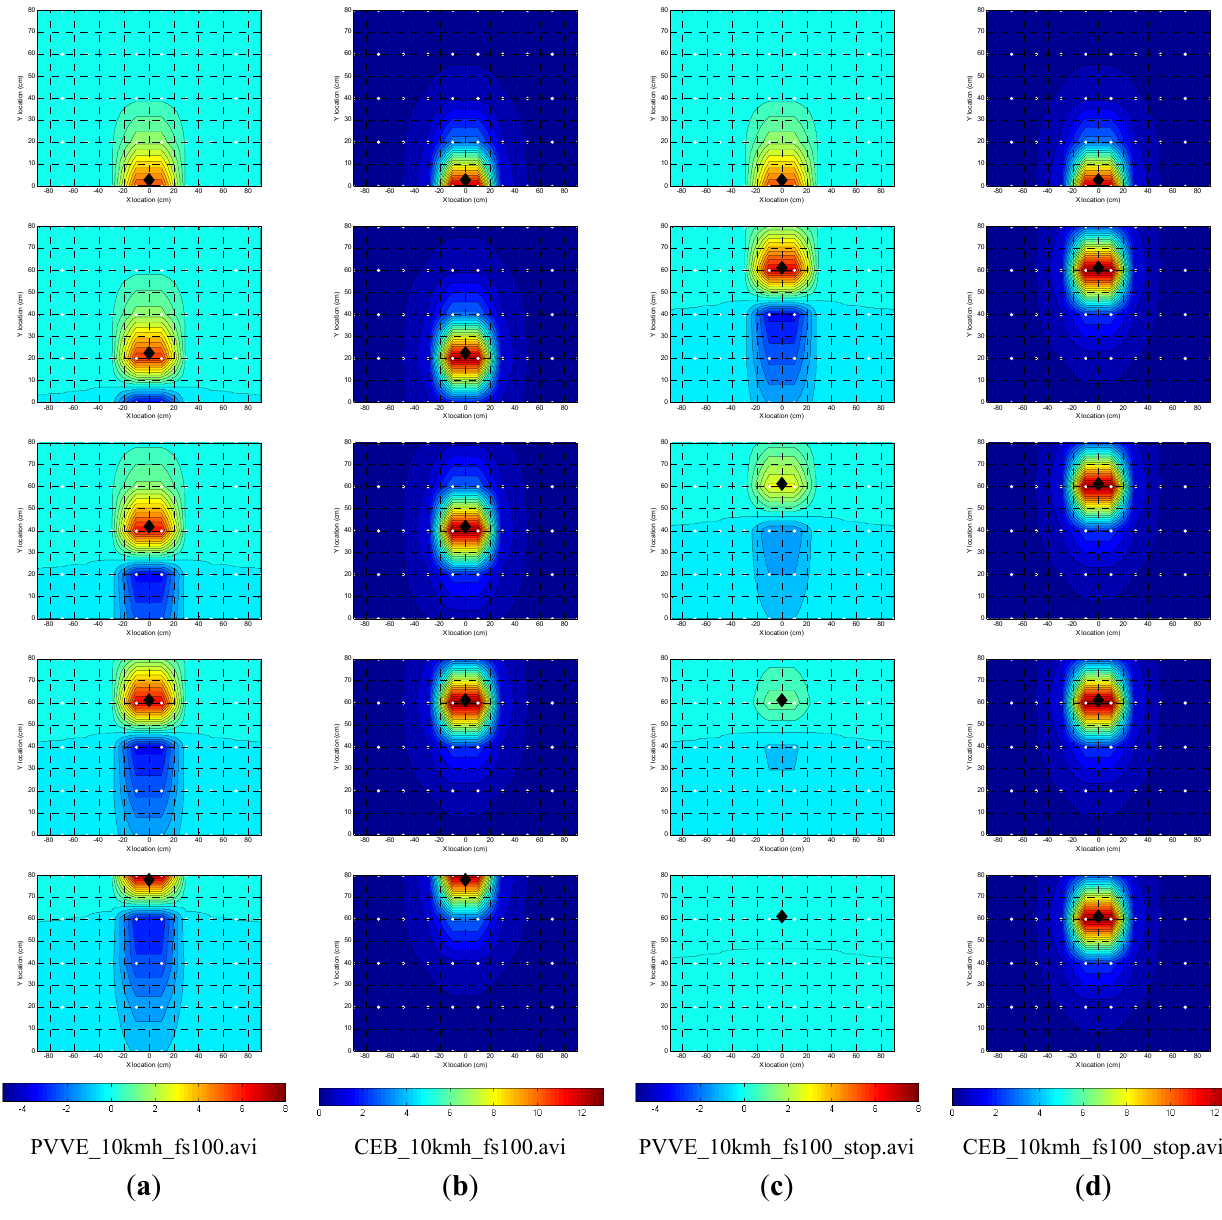
The CEB localization system exhibits a positive hill along with target location and the PVVE system presents a positive hill as well as the negative valley right after target trail. Note that the color maps of the PVVE and CEB localization system are not identical and illustrated in the second to last row. Both systems can discover the target coordinates by estimation of the positive center from the contour distribution. The shape of the hill in the PVVE system displays the asymmetric property in the movement direction and zero crossing indicates that the vehicle starts to withdraw from the